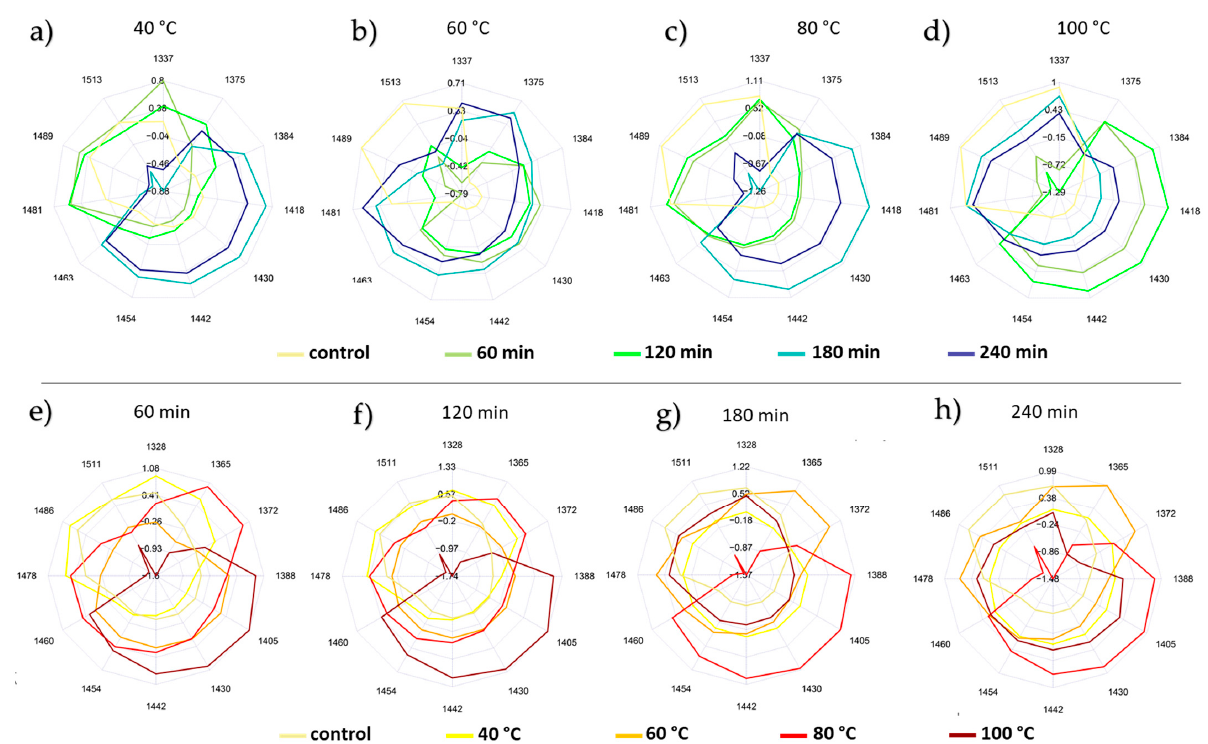
Figure 6. Aquagrams of the acacia honey: ( a – d ) aquagrams showing pattern of time intervals; ( e – h ) aquagrams showing the pattern of temperature level. ( e – h ) aquagrams showing the pattern of temperature